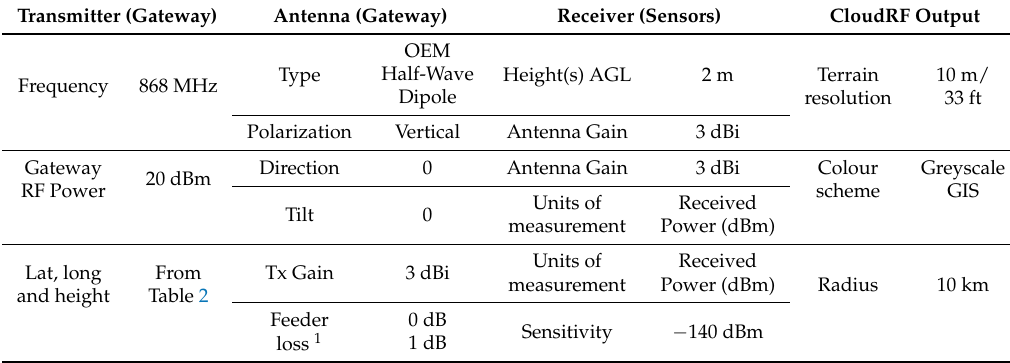
Table 4. CloudRF common parameters for all